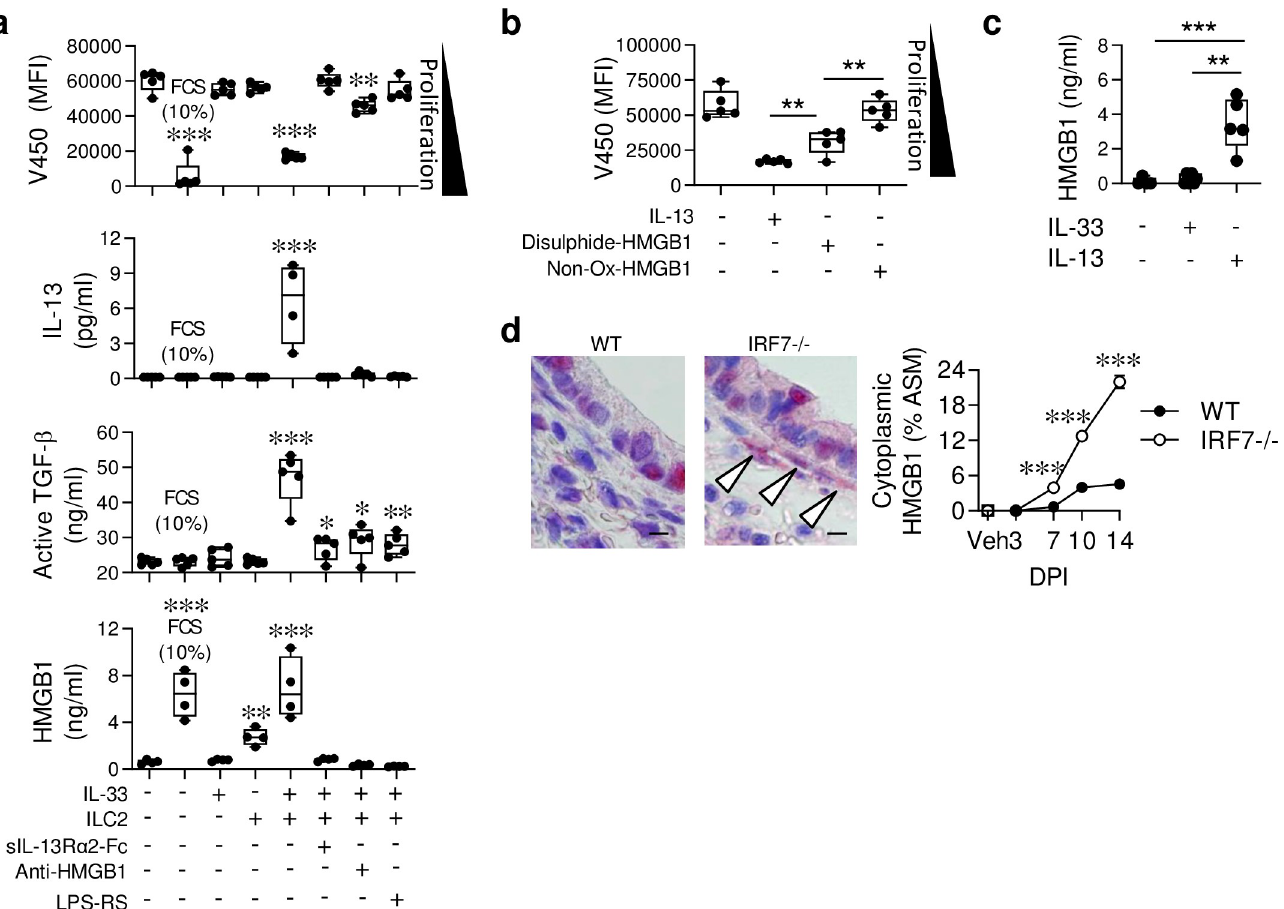
Fig 5. Activated ILC2s induce ASM proliferation in vitro in an HMGB1-dependent manner. (a-b) Primary ASM cells were isolated from na ï ve WT neonatal mice and cultured with ILC2s (purified from the lungs of IRF7 -/- mice at 10 dpi) in the presence of various stimuli as indicated. (a) ASM proliferation (indicated by decreasing median fluorescence intensity (MFI)), IL-13, active TGF β and HMGB1 concentration in the culture supernatant. � Compared to ASM cells cultured in the absence of ILC2s or cytokine stimulation. (b) ASM proliferation in response to IL-13 (3 ng/ml), disulphide HMGB1 (30 ng/ml), or a non-oxidisable mutant HMGB1 (30 ng/ml). � Compared to IL-13-stimulated ASM cells with disulphide-HMGB1-stimulated ASM cells or disulphide-HMGB1-stimulated ASM cells with non-oxidisable mutant HMGB1-stimulated ASM cells as indicated. (c) HMGB1 protein expression in the supernatant of ASM cells cultured in the presence of IL- 33 or IL-13 as indicated. (d) Representative micrograph (x1000 magnification) of HMGB1 immunoreactivity (red) in the lung at 10 dpi, arrows indicate expression by ASM cells. Bar, 5 μ m. Quantification of HMGB1 expression by ASM cells. For panel a-d, data are representative of one experiment, performed twice with similar results. For panel e, data are representative of n = 2 experiments with four to eight neonates in each group. Data are presented as box-and-whisker plots showing quartiles (boxes) and range (whiskers; a-d) or as mean ± SEM (e [right]). Data were analysed by One-way ANOVA with Dunnett post hoc test (a-d) or Two-way ANOVA with Tukey post hoc test (e ([right]; � , P < 0.05; �� , P < 0.01; ��� , P < 0.001 compared to the respective control